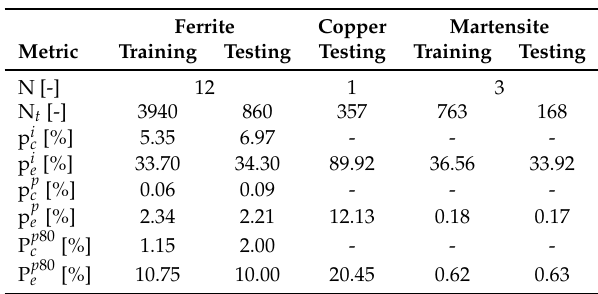
Table 1. Overview of data